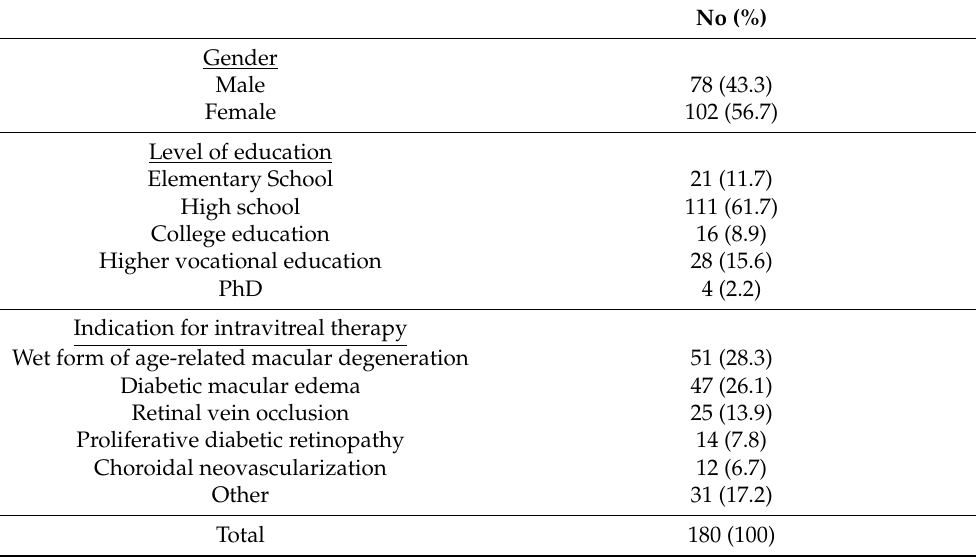
Table 1. Basic characteristics of the